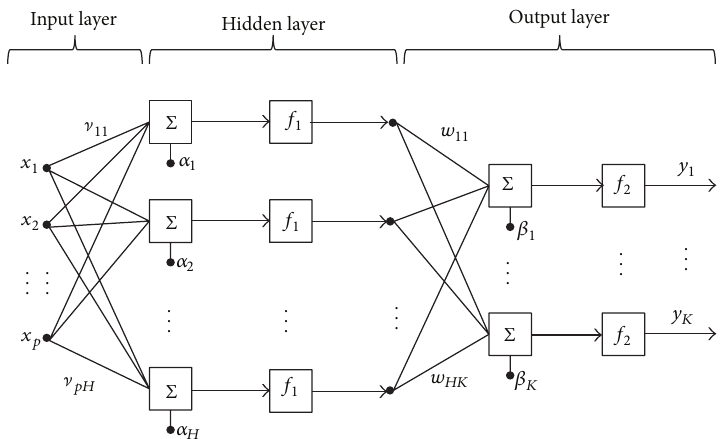
Figure 9: Architecture of the three-layer feedforward neural network.